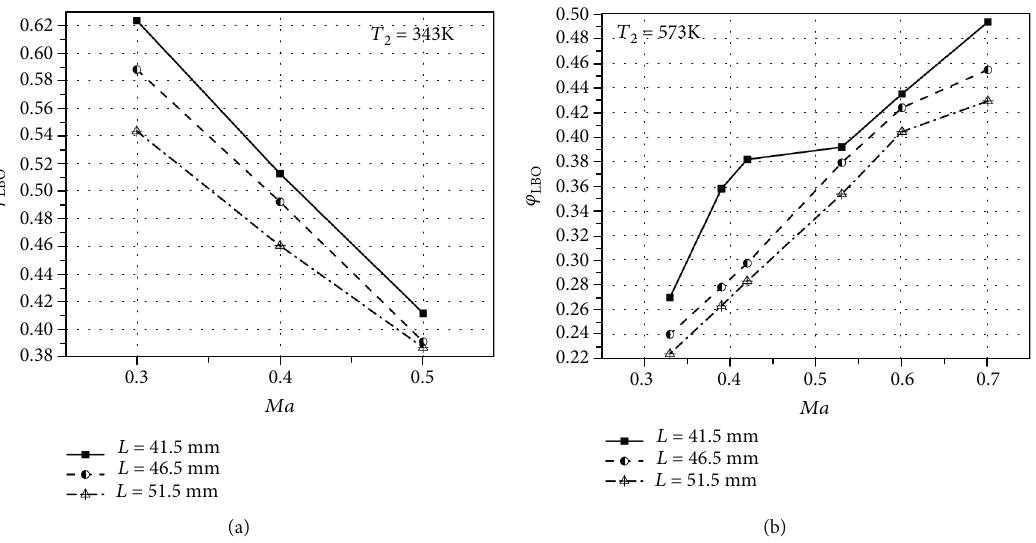
= 343 K , (b) T = 573K 2 2